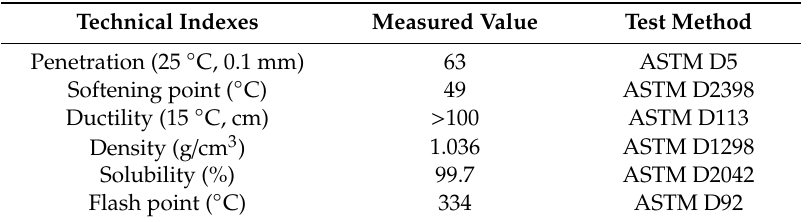
Table 1. A-70 base asphalt (virgin) performance parameters.